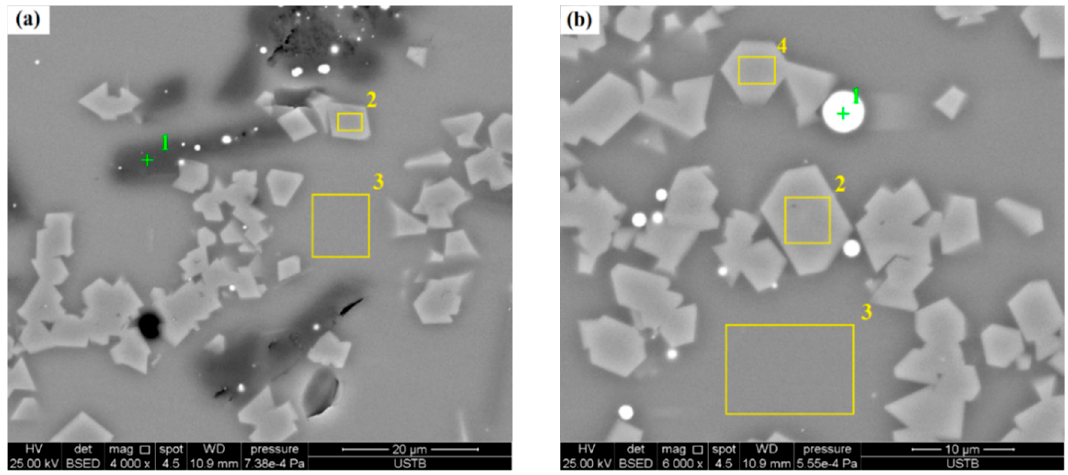
Figure 16. SEM micrographs of the alumina slag with alumina phase ( a ) and the alumina slag ( b ) obtained at the optimal condition. Table 4. EDS results of the alumina slag obtained at the optimal condition.